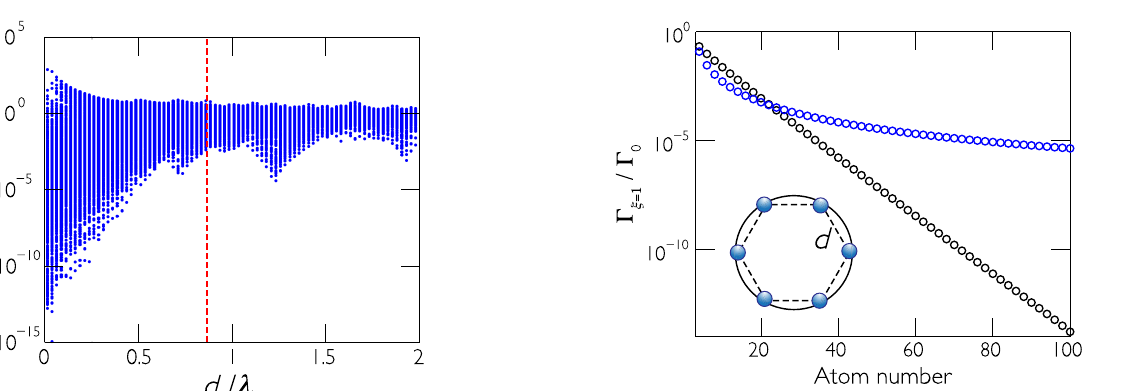
FIG. 6. Decay rates of the N 3 modes at different lattice constants d= λ 0 for a cubic lattice of 10 × 10 × 10 atoms with linear polarization along one of the lattice axes. The dashed red line corresponds to the particular value of d= λ 0 ¼ the light line touches the edge of the first Brillouin zone in 3D. In 3D, subradiant states can exist even beyond this value.